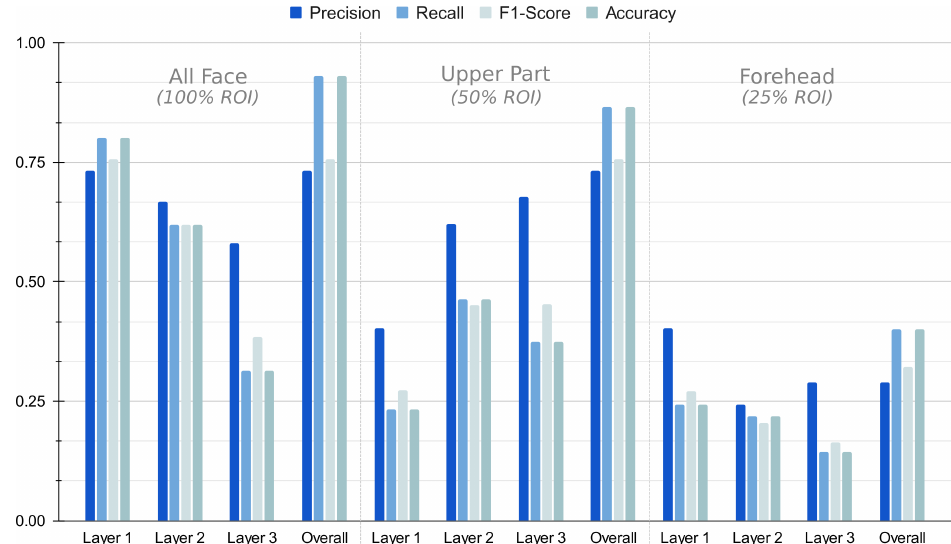
Figure 14. Performance metrics for the AP-SVM tree with different visible parts of the face.